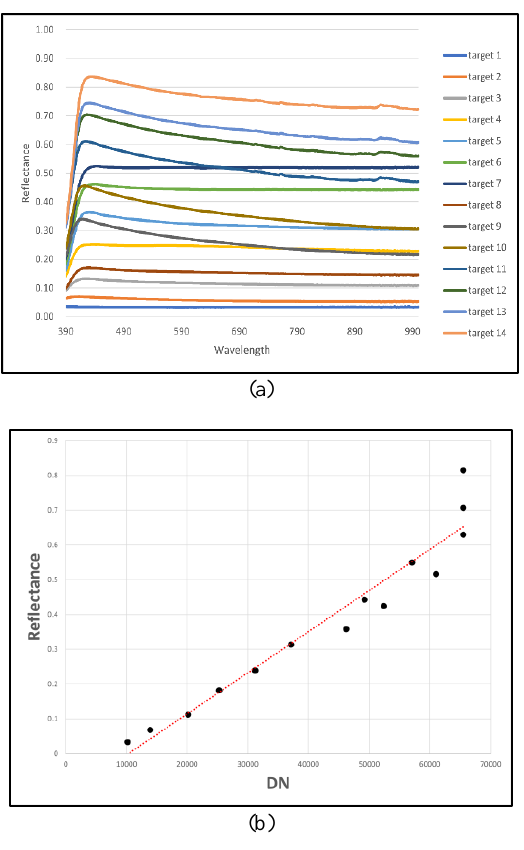
Figure 4. (a) Spectral reflectance of reference targets (b) Linearity between DN and reflectance of reference